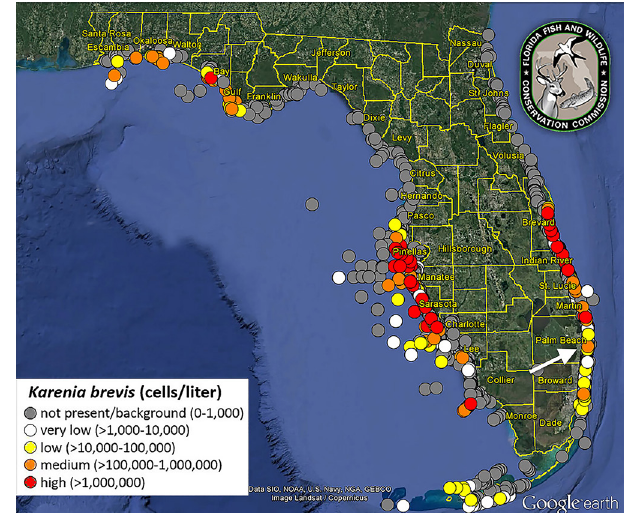
Figure. Map showing the statewide Karenia brevis concentrations October 1-31, 2018. Location of patient’s red tide exposure (white arrow). Reprinted with permission from the research institute of the Florida Fish and Wildlife Conservation Commission.